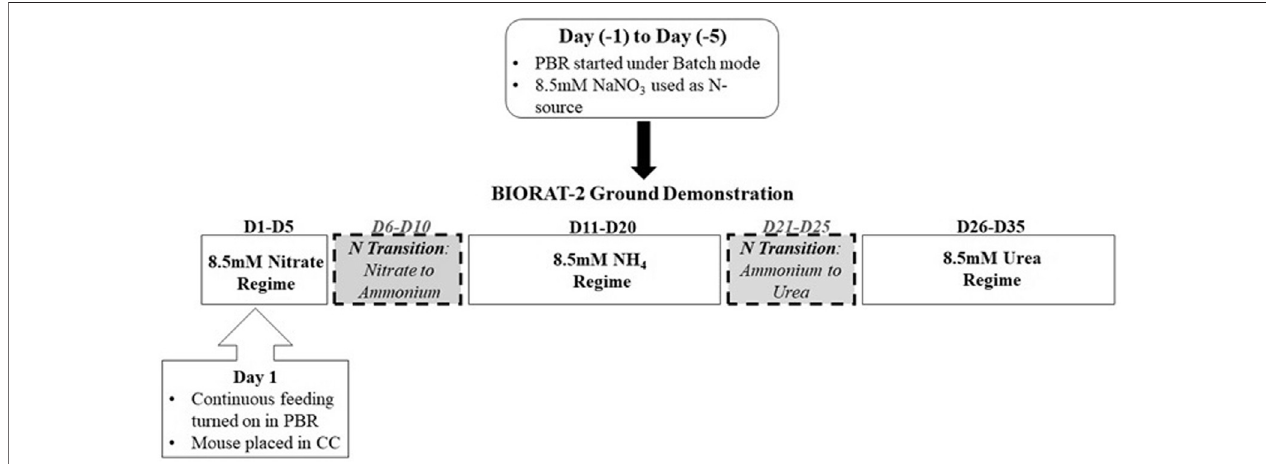
FIGURE 2 | Schematic of the timelines and study protocol adopted for the ground demonstration